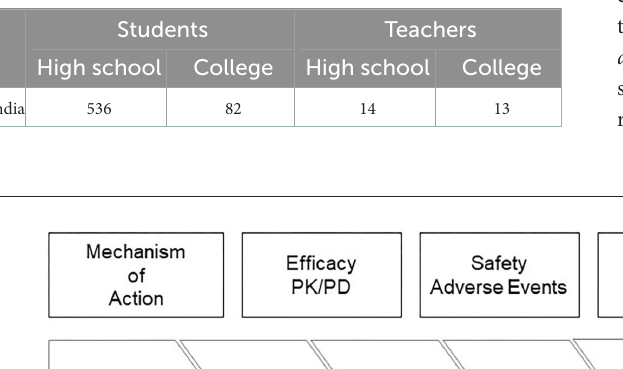
TABLE 1 Demographics of survey respondents.